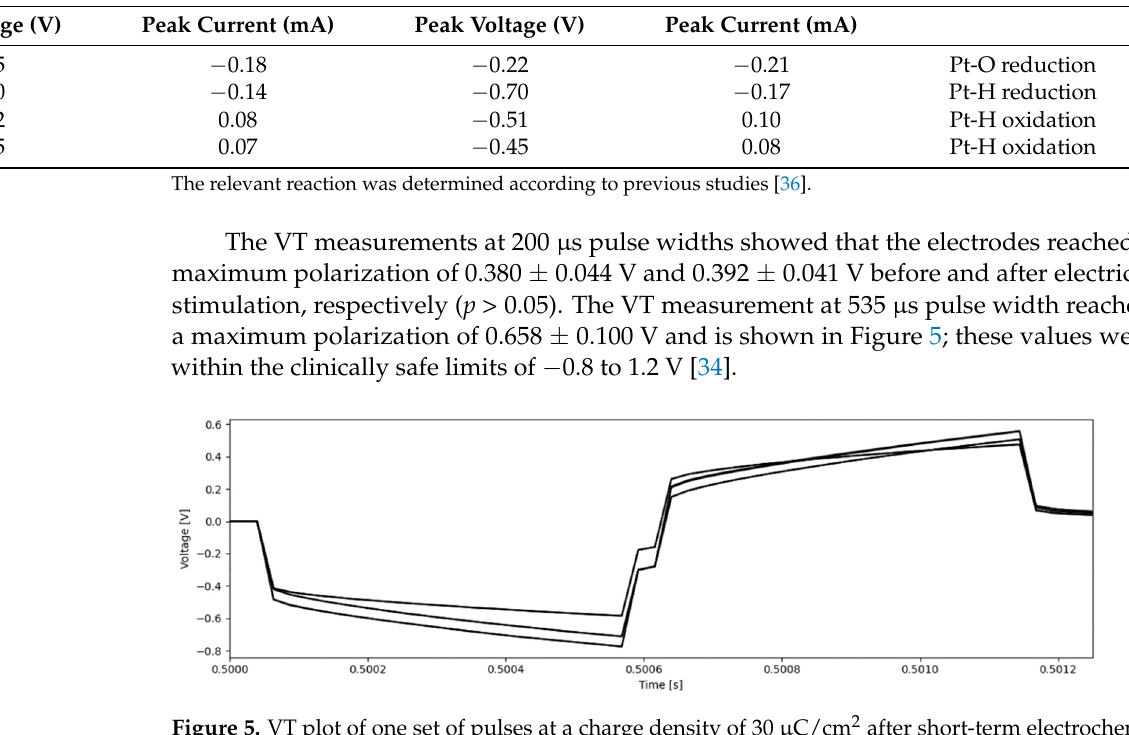
Figure 5. VT plot of one set of pulses at a charge density of 30 µC/cm 2 after short-term electro- chemical testing.